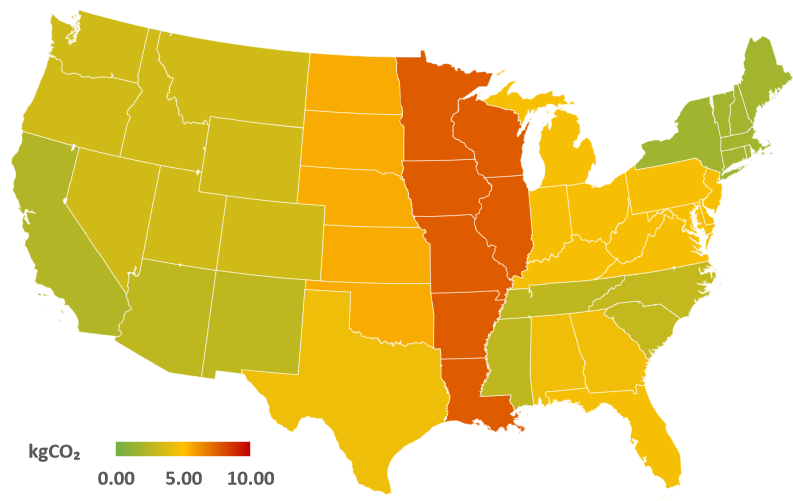
Figure 9. GHG emissions per day due to the charging of one EV in